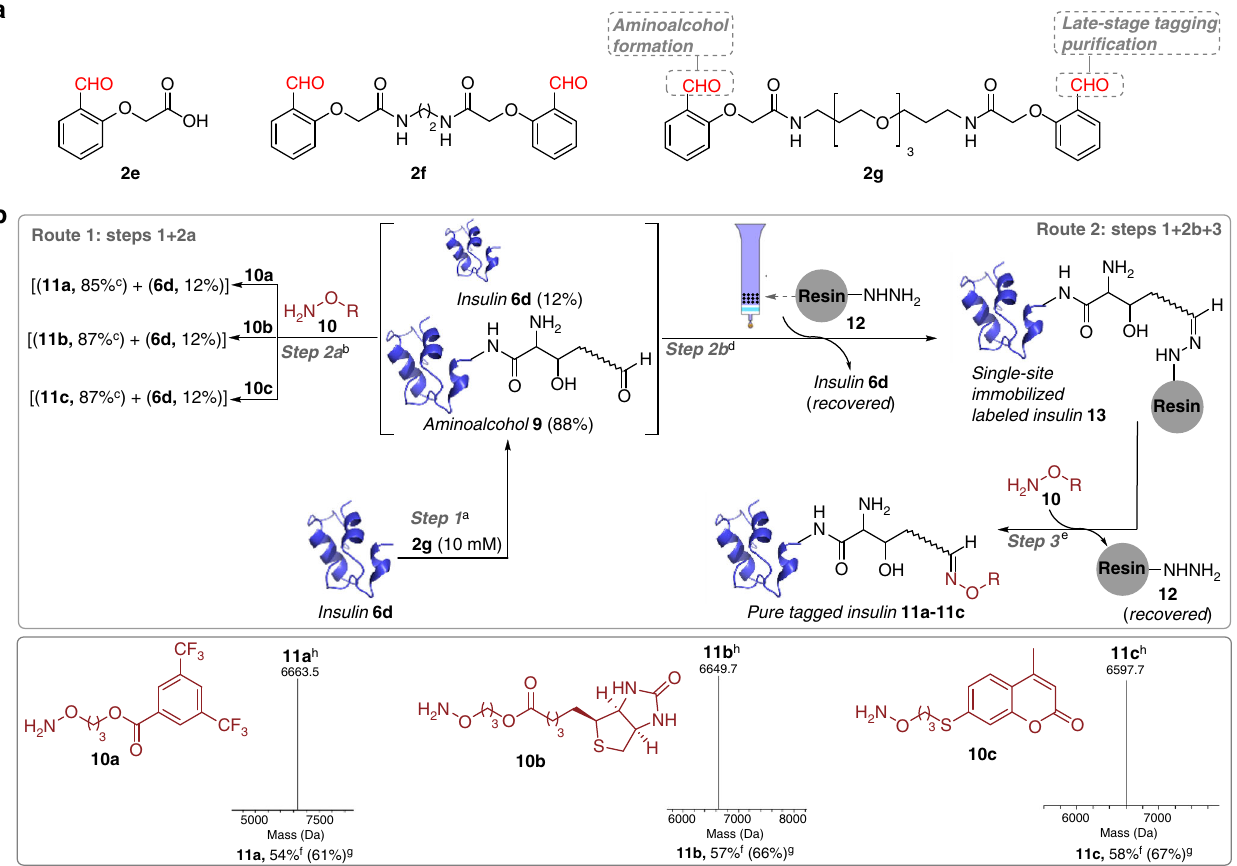
Fig. 4 Late-stage tagging and isolation of analytically pure tagged proteins. a Design elements of a symmetric bis-aldehyde. b Insulin is labeled through aminoalcohol formation with reagent 2g . The labeled insulin 9 can be treated with derivatives of O-hydroxylamine 10a – 10c for tagging them with 19 F-NMR probe, biotin, and coumarin. Alternatively, it can be immobilized on hydrazide functionalized resin through single-site to deliver 13 . The unreacted insulin 6d is recovered and recycled. Subsequent treatment of 13 with 10a delivers analytically pure 11a after removing excess 10a through spin concentration. The hydrazide functionalized resin 12 is recovered and recycled multiple (5 – 8) times without loss of activity. Similar protocol renders pure 11b and 11c . For single-step late-stage installation of a probe, please see Supplementary Fig.